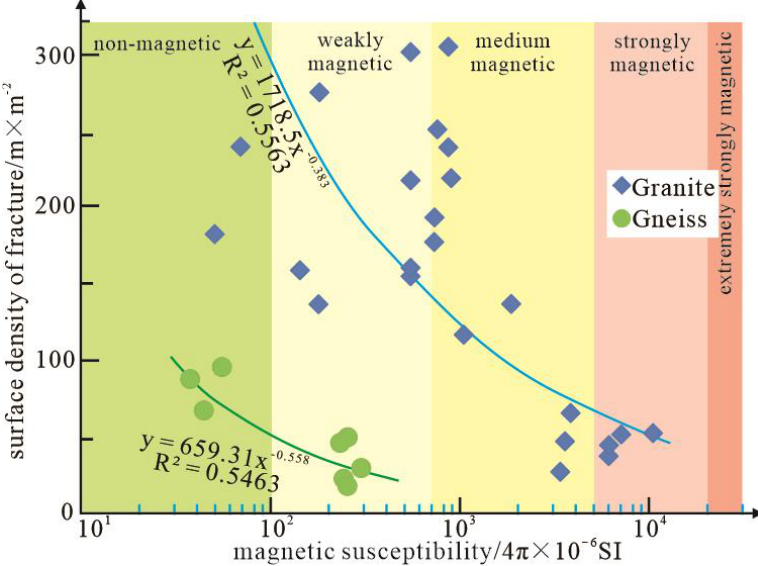
Figure 12. Plot of magnetic susceptibility versus fracture density for basement rocks in the LS depression. Note: Outcrops with measured fracture density were marked with red points in Figure 1b.